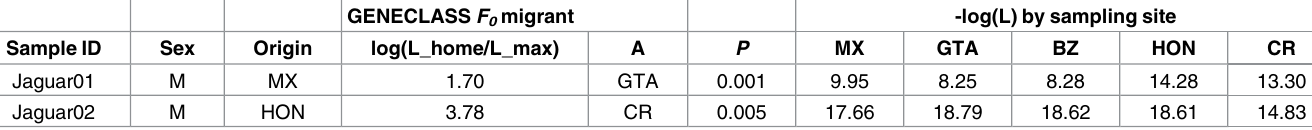
Table 3. First-generation migrant analysis indicating dispersers in Mesoamerican jaguars.